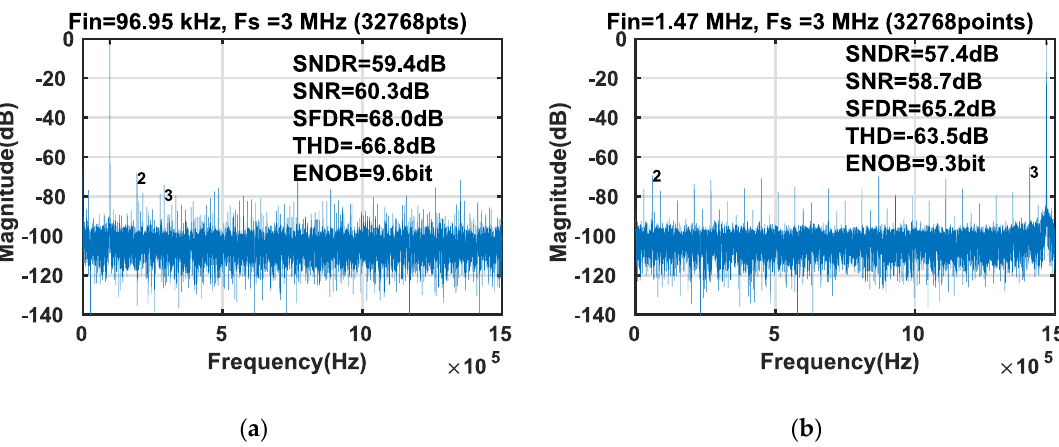
Figure 14. Measured output spectrum of prototype SAR ADC with ( a ) a near 100 kHz sinusoidal input; ( b ) a near 1.5 MHz sinusoidal input. Table 2. Performance summary and comparison.